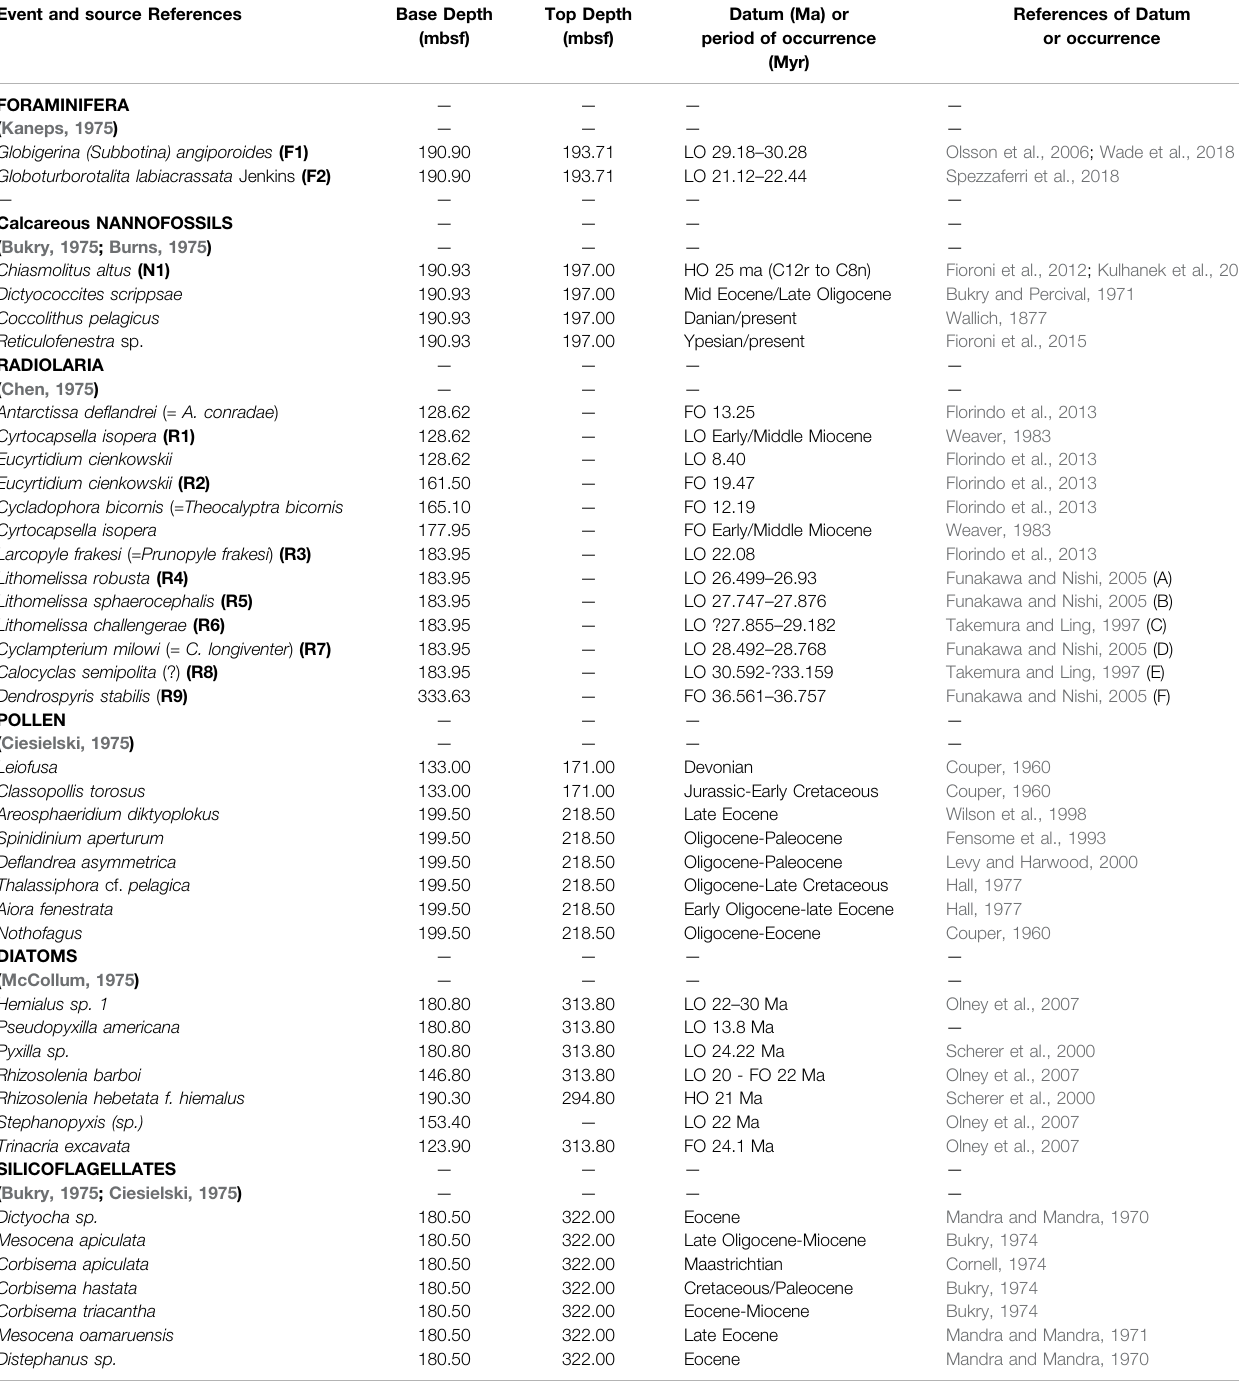
TABLE 1 | Biostratigraphic data from previous studies in the DSDP Initial Reports -Hayes et al. (1975), Radiolaria (Chen, 1975), Diatoms (McCollum, 1975), Silico fl agellates (Ciesielski, 1975), Planktonic Foraminifera (Kaneps, 1975), Calcareous nannoplankton (Bukry, 1975; Burns, 1975) - used to correlate of the DSDP Site 274 magnetic polarityzonationwiththeGeomagneticPolarityTimeScale.Agesforradiolariandatumlevelswereassigned,whereavailable,bythecompositeorderingofeventsandhybrid age model output from constrained optimization (CONOP) analyses of Southern Hemisphere data sets and Ocean Drilling Program (ODP) Site 744 (Florindo et al., 2013). AgesforallothereventsareasreportedinthebiozonationbyTakemuraandLing(1997),orfromotherreports,suchasWeaver(1983).Theagecalibrationsoftheevents reportedinFunakawaandNishi(2005)andTakemuraandLing(1997)wereconvertedtotheGradsteinetal.(2012)timescalefromtheoriginalBerggrenetal.(1995)age calibration, using the converter at: http://www.odsn.de/cgi-bin/conv_ts.pl; (A) 27.1 – 27.5, (B) 28.2 – 28.3, (C) ?28.28 – 29.40, (D) 28.9 – 29.1, (E) 30.48-?33.06, (F) 36. 2 –